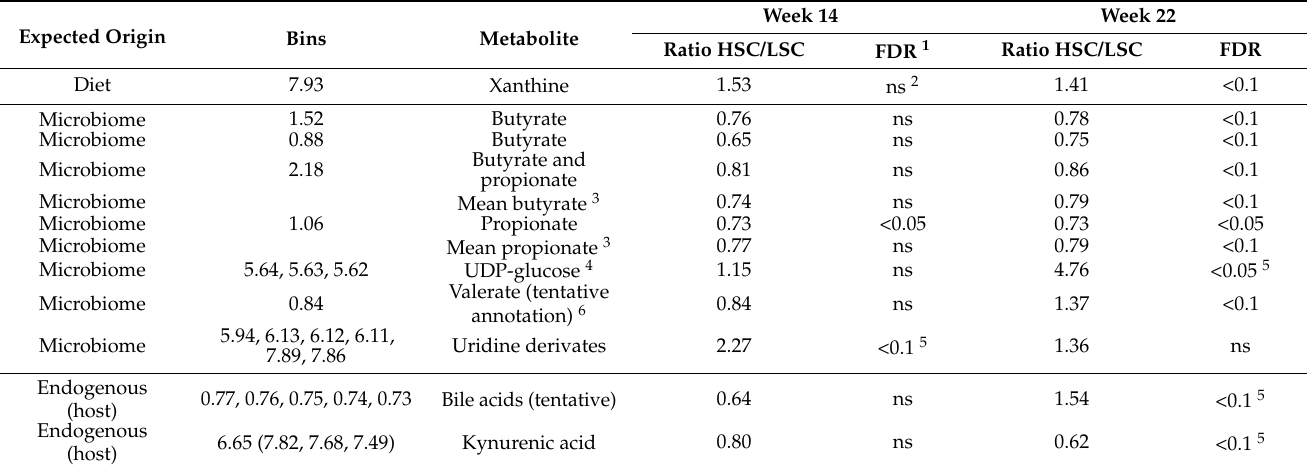
Table 1. Metabolites showing different ratios in feces of pigs kept in high (HSC) or low sanitary conditions (LSC) at 14 and 22 weeks of